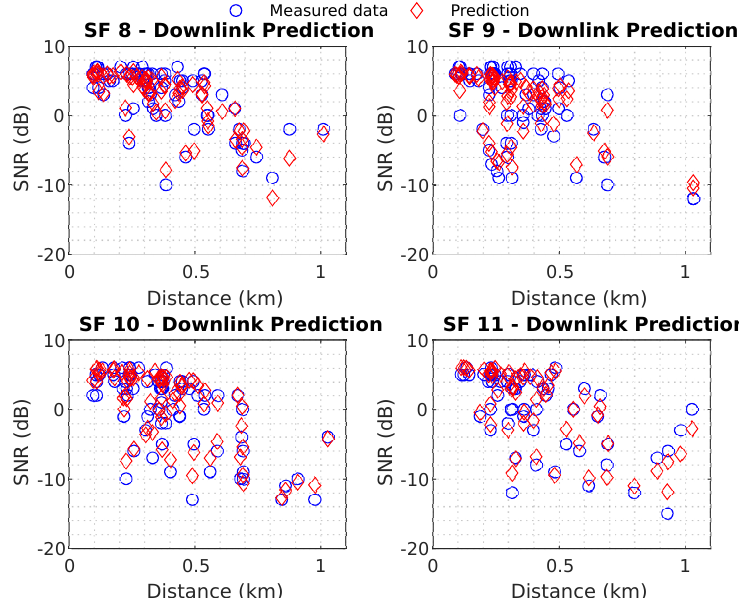
Figure 13. Downlink Best Neural Network.